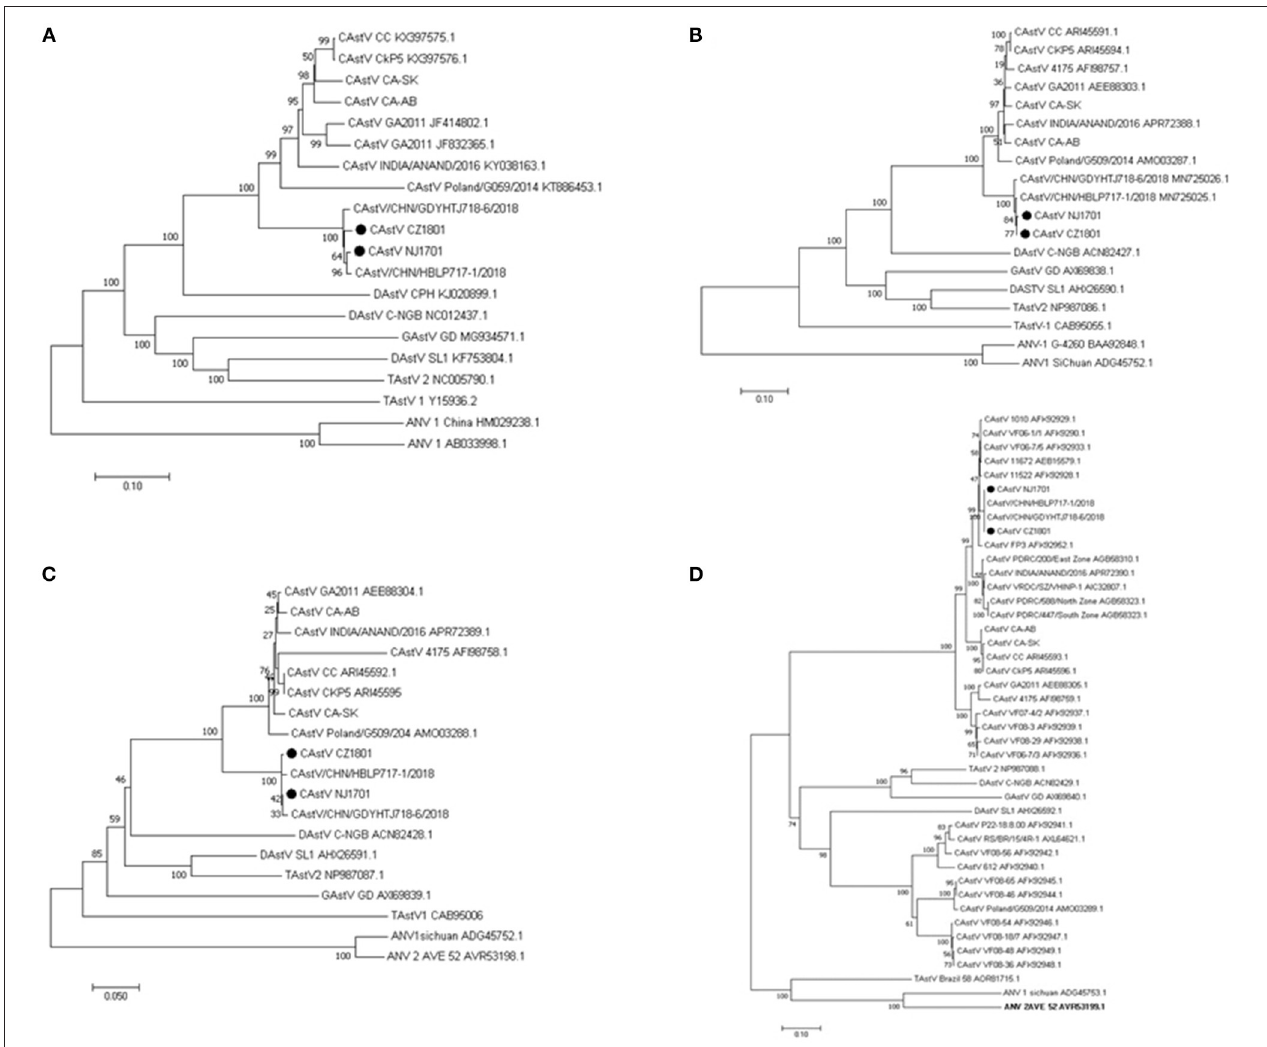
FIGURE 2 | Phylogenetic relationships between the two CAstV isolates from this study and other astroviruses. The analysis was based on the nucleotide sequences of the complete genome (A) and on amino acid sequences of the complete ORF1a (B) , ORF1b (C) , and ORF2 (D) regions. The phylogenetic trees were constructed using MEGA X, the neighbor-joining method and 1,000 bootstrap replicates. GenBank accession number of the sequences are indicated in parentheses. The scale bar corresponds to genetic distance. “•” indicates the isolates analyzed in this